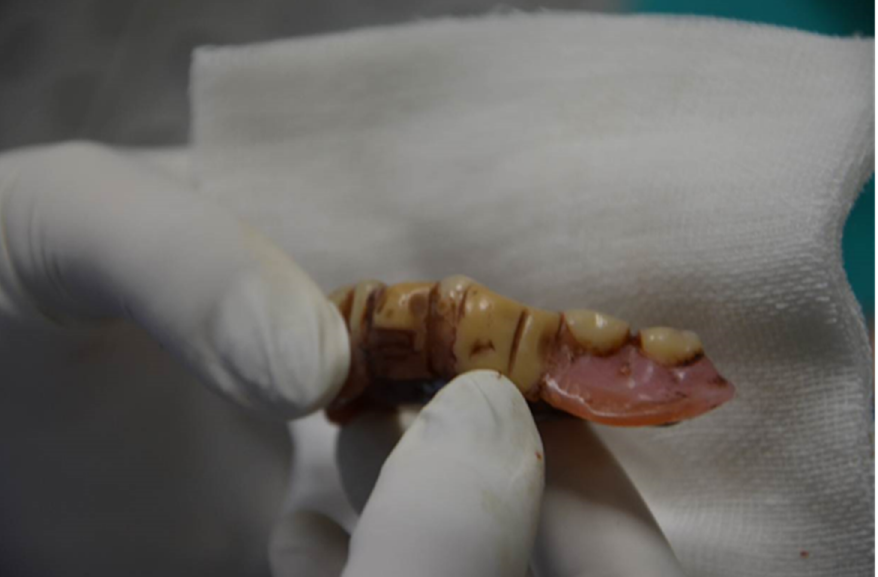
Figure 4. Two dental prosthetic elements of the mandibular arch were scratched on the front surface with non-serrated margins, such as a negative impression of the sharp blade of the medium used.